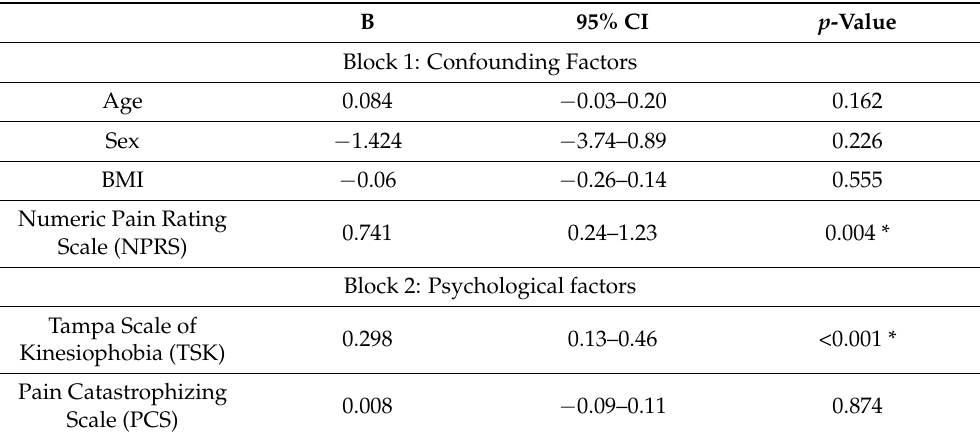
Table 3. Multivariable linear regression model examining the independent effect of demographic features and psychological components of kinesiophobia (TSK score) and pain catastrophizing (PCS score) on pain-related disability (RMDQ score) B 95% CI p -Value Block 1: Confounding Factors Age 0.084 − 0.03–0.20 0.162 Sex − 1.424 − 3.74–0.89 0.226 BMI − 0.06 − 0.26–0.14 0.555 Numeric Pain Rating 0.741 0.24–1.23 0.004 Scale (NPRS)